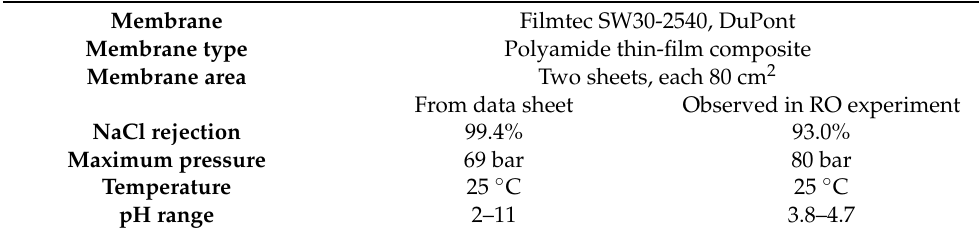
Table 2. Membrane specifications and experimental conditions of the RO